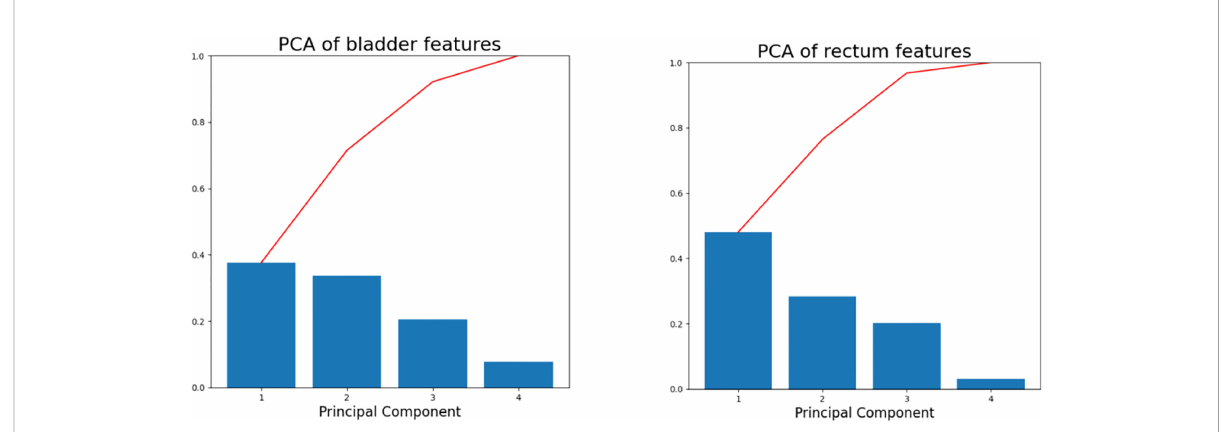
FIGURE 2 Scree plots of the bladder (left) and rectum (right) after PCA was applied to the training database. The percentage of variance represented by individual PC is plotted in descending order as blue bars, and the cumulative total is represented by red